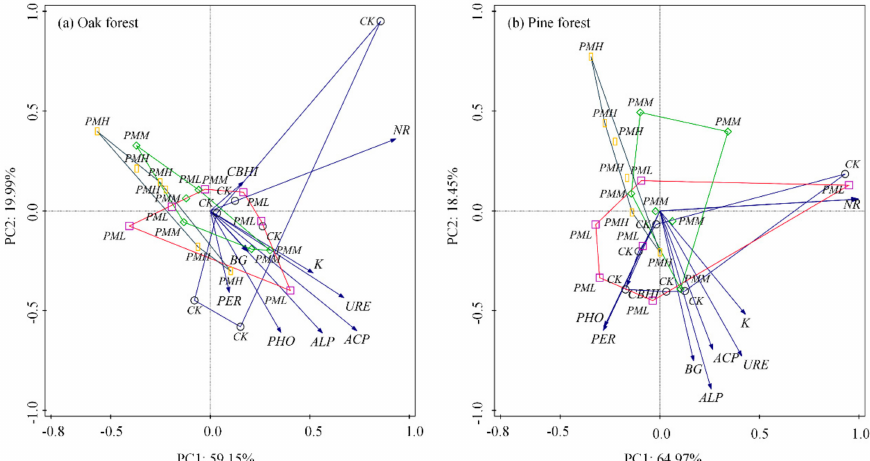
Figure 5. Principal component analysis (PCA) ordination of enzymatic activities (arrows), decomposition coefficient( k ), andfourtreatmentsinthe( a )oakand( b )pineforests. Thetraitswerecenteredandtransformed logarithmically prior to ordination. Variance explained by each principal component (PC) are shown. CBH1: cellobiohydrolase; BG: β -1,4-glucosidase; NR: nitrate reductase; URE: urease; ACP: acid phosphatase; ALP: alkaline phosphatase; PER: peroxidase; PHO: phenol oxidase. Legend: black circles represent CK; purple squares represent PML; green rhombuses represent PMM, and yellow rectangles represent